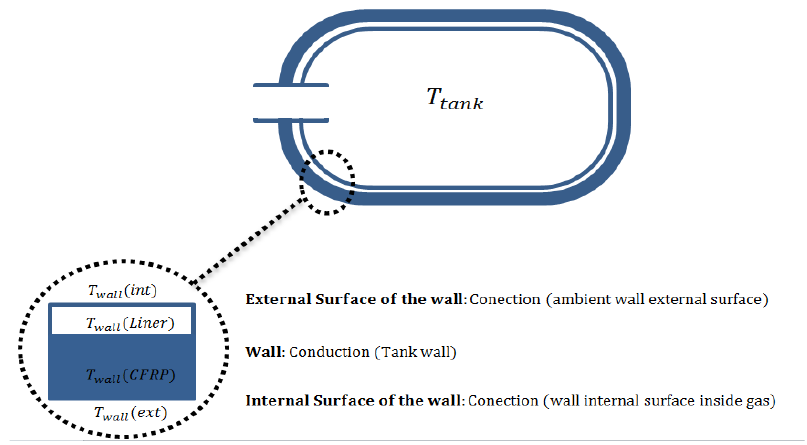
Figure 9. Hydrogen tank. Figure 9. Hydrogen